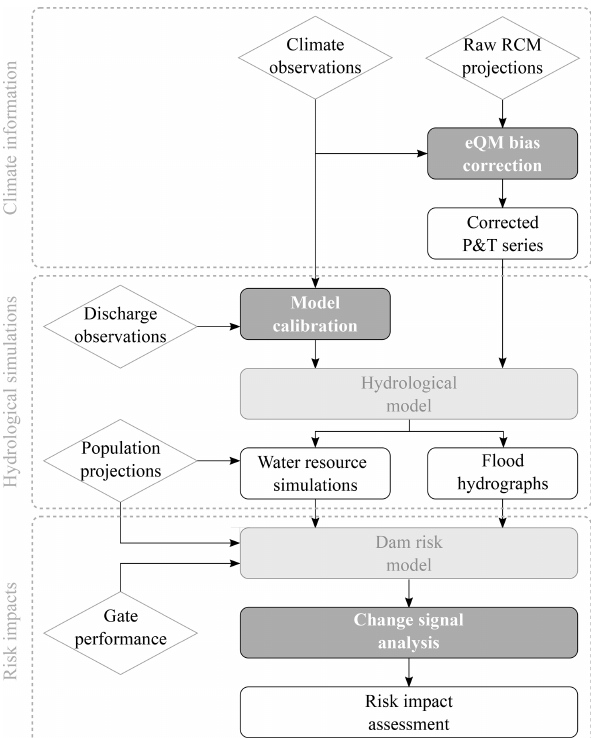
Figure 1. Workflow of the methodology followed to assess climate change impacts on dam failure